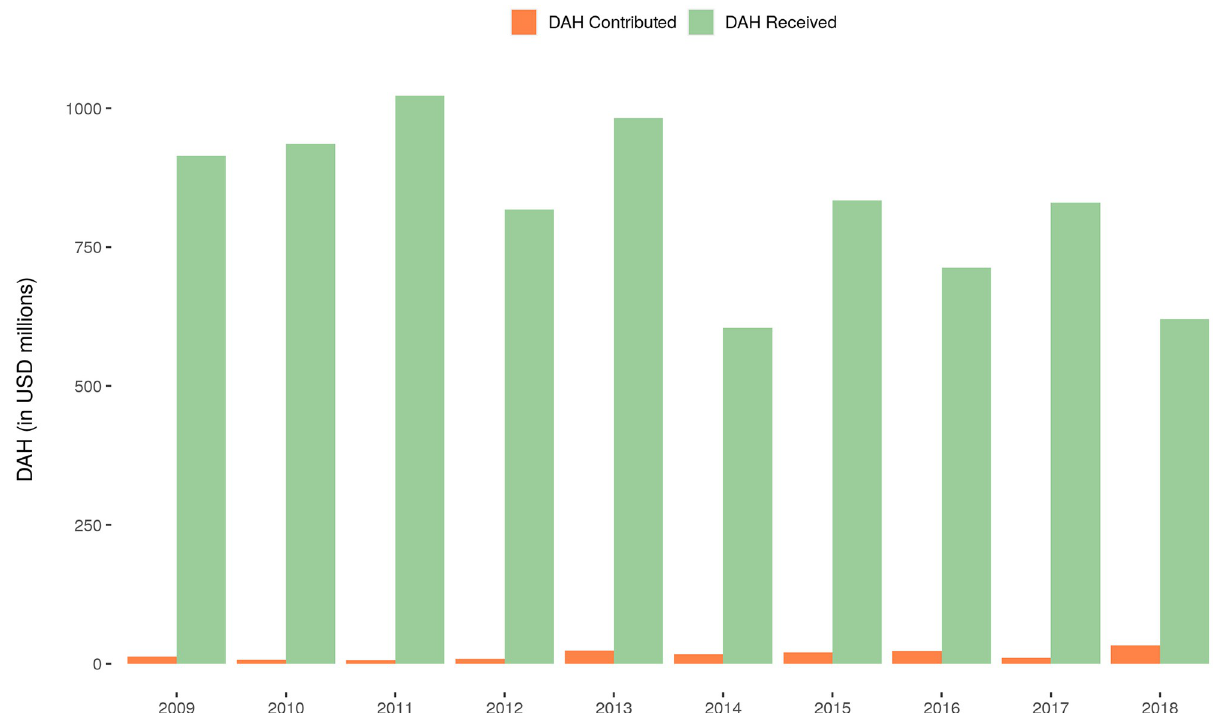
Fig 3. Bilateral DAH received and contributed by India, 2009–2018. Note: This figure uses data on DAH received by India from Micah et al. (2021) which reports DAH received by India up to